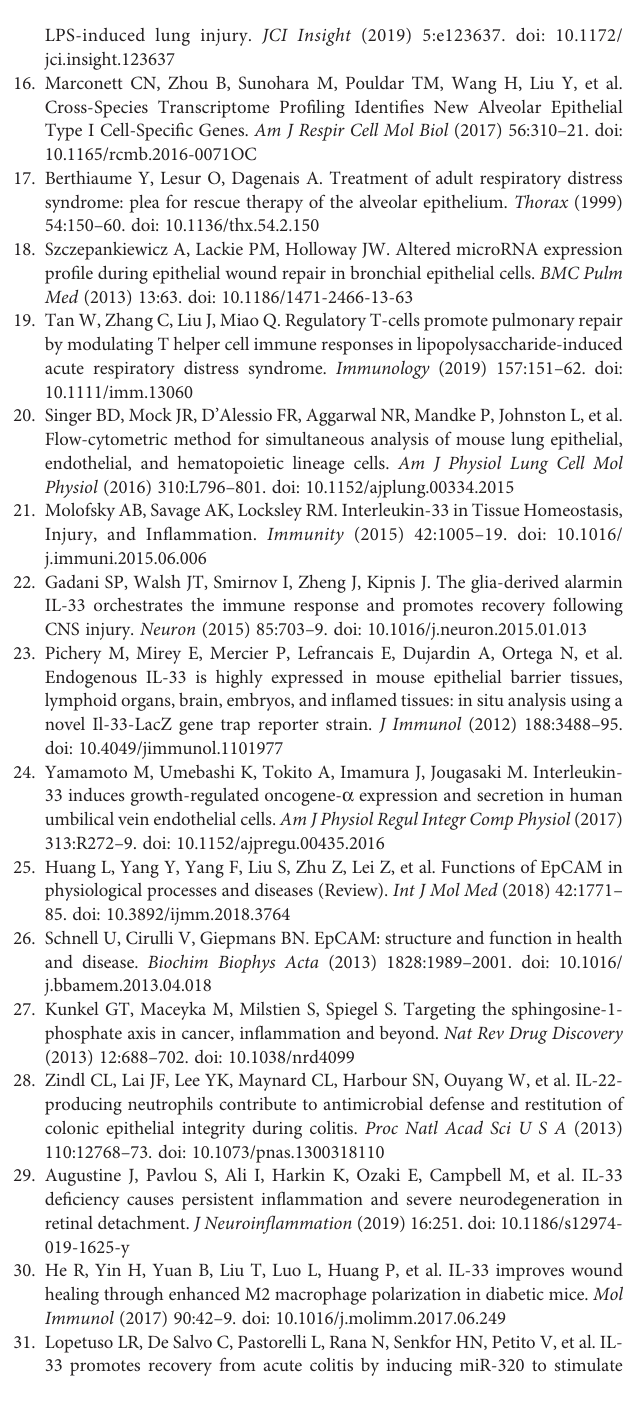
microscopy of lung sections from the sham group, L2 group, and L4 group. Scale bars represent 50 µm. Supplementary Figure 2 | the Tconv cell population did not change after IL-33 treatmentineitherthelungorspleen. (A) FractionofTconvcellinthelungafterIL-33 treatment. (B) Number of Tconv cell in the lung after IL-33 treatment. (C) Fraction of Tconv cellin the spleen after IL-33treatment. (D) Number ofTconv cell in the spleen after IL-33 treatment. Statistical analysis of this fi gure ’ s data is shown in Figure 1 . n = 6 mice per